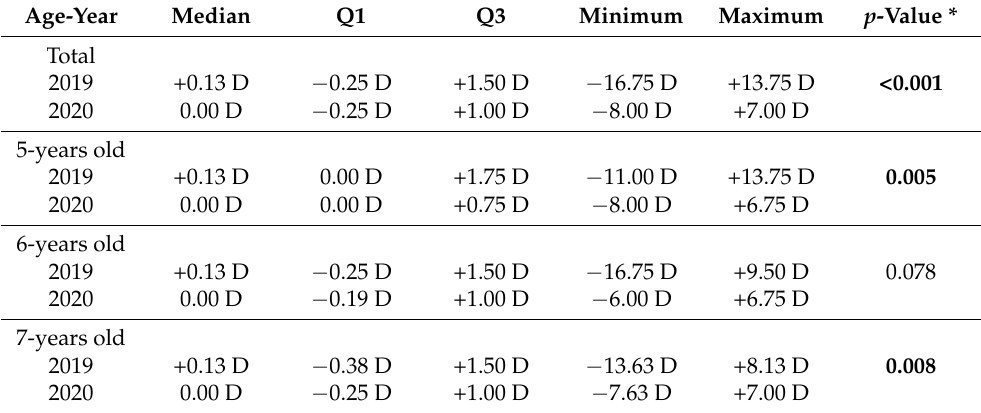
Table 2. Right eye spherical equivalent (SE) values for children examined in 2019 and 2020.